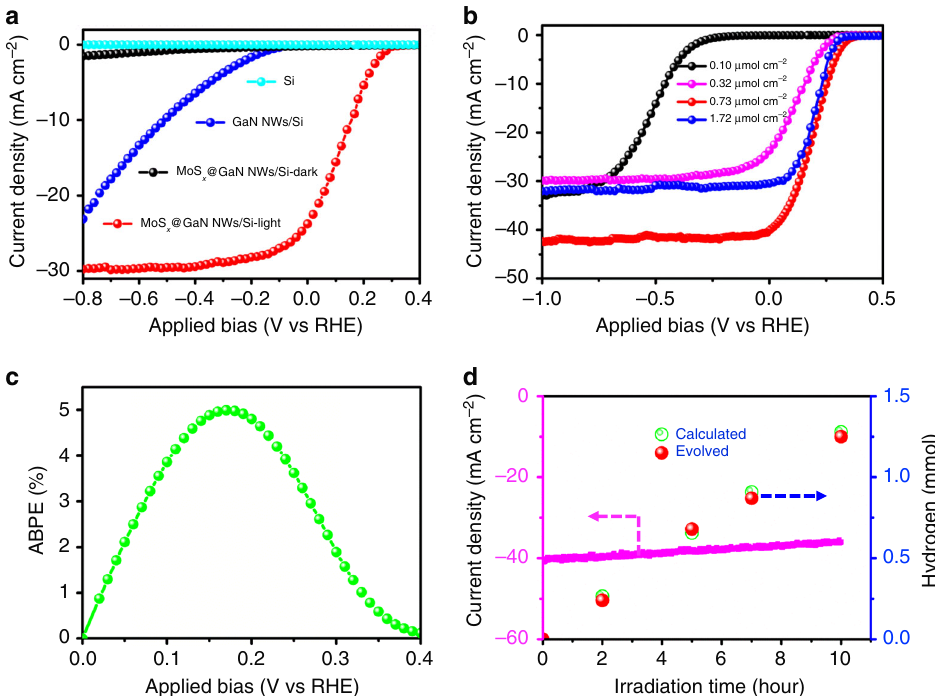
Fig. 3 PEC water splitting performance in 0.5 M H 2 SO 4 under standard one-sun illumination. a J – E curves of various photocathodes of planar n + – p junction Si, GaN NWs/Si, and MoS x @GaN NWs/Si. b J – E curves of MoS x @GaN NWs/Si with different loading densities of MoS x . c ABPE of MoS x @GaN NWs/Si with 0.73 μ mol cm − 2 of MoS x versus applied potential. d Stability and Faradaic ef fi ciency measurements of MoS x @GaN